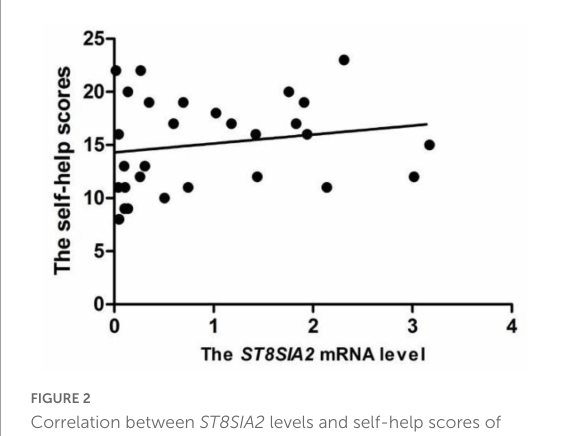
FIGURE2 Correlation between ST8SIA2 levels and self-help scores of Infant-Junior Middle School Students Social-Life Abilities Scale ( N ASD = 30, r = 0.462, p = 0.021 from Pearson’s correlation analysis).